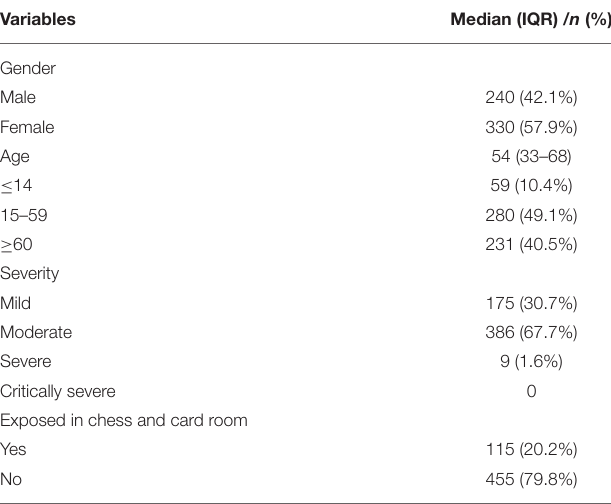
TABLE 1 | Characteristics of cases in Yangzhou from 28 July to 26 August 2021 (Laboratory-confirmed cases, China, 2021).